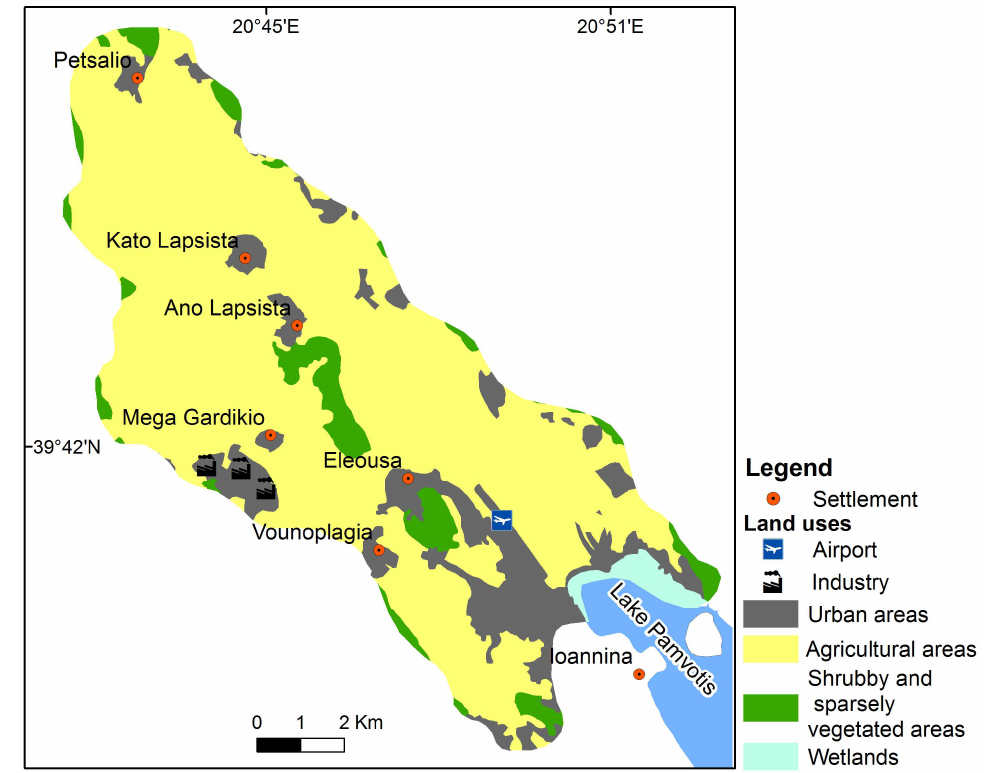
Figure 3. Land use in the Ioannina